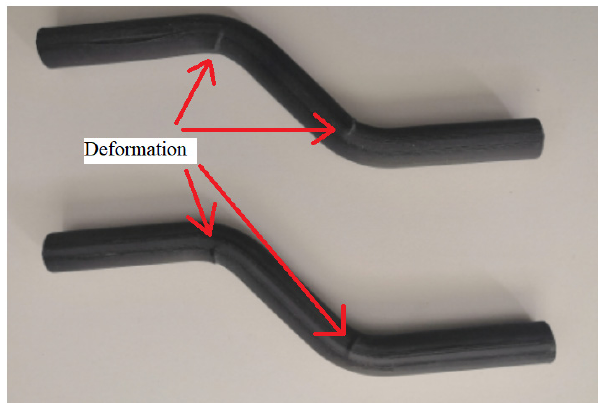
Figure 5. CFRP profiles deformation after buckling test.